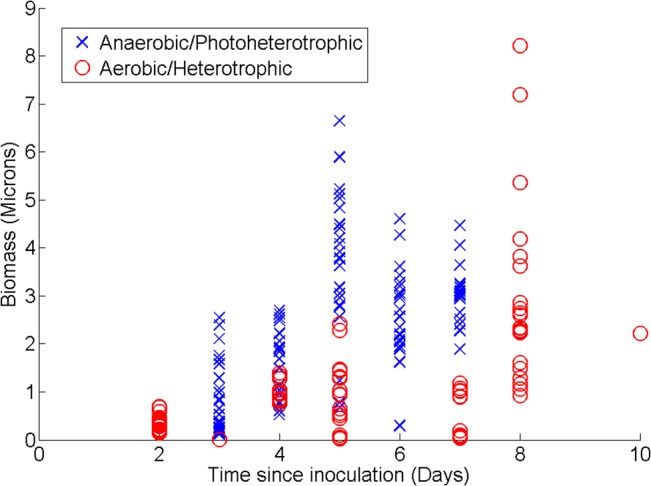
Biomass versus time since inoculation of R. palustris biofilms formed under aerobic and anaerobic conditions.A modified implementation of the COMSTAT methods [16] was used to quantify the biomass of anaerobic and aerobic biofilms. Each data point represents an individual scan.